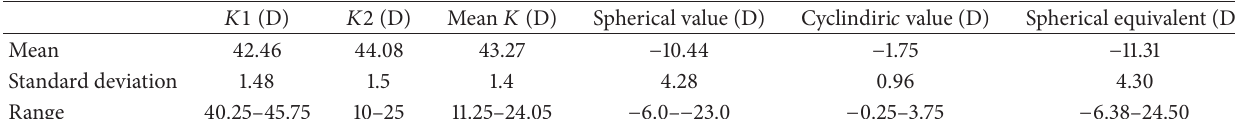
Table 2: Refractive errors and keratometry values.